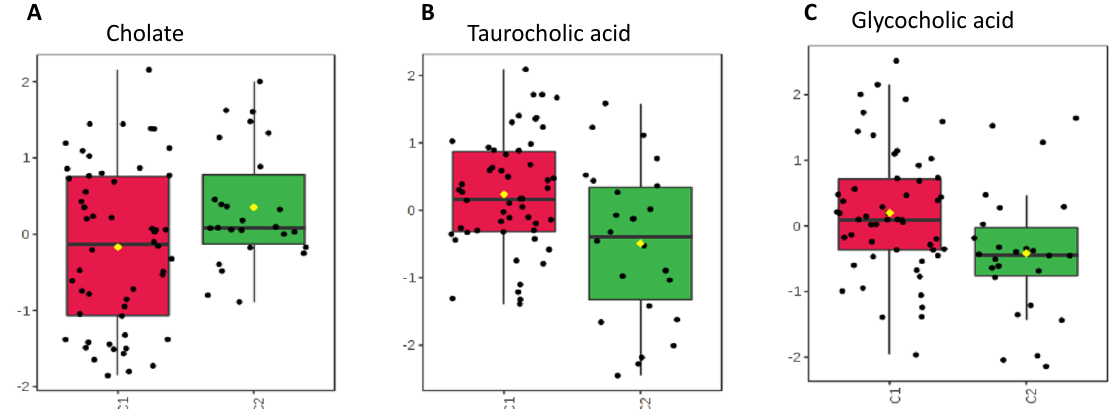
Figure 4. Concentrations compared between groups C1 and C2. ( A ) Primary bile acid, cholate, with unchanged level despite antibiotic administration ( p > 0.05). ( B , C ) Conjugated bile acids taurocholic acid and glycocholic acid. Both with increased expression in the group given antibiotics ( p = 0.043 for taurocholic acid, p = 0.047 for glycocholic acid).